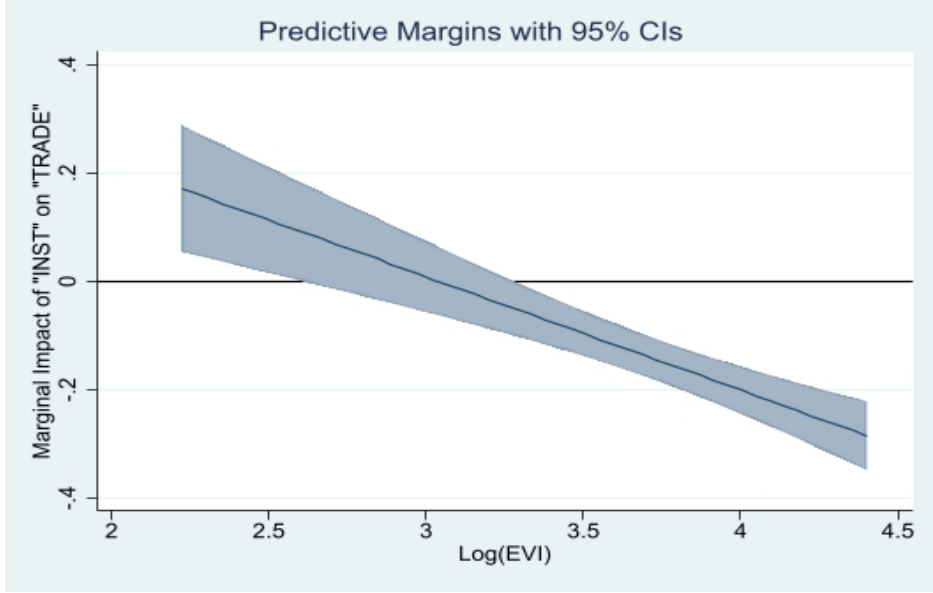
Figure 4. Marginal impact of “INST” on “TRADE” for varying levels of EVI. Source: Author. Outcomes in columns (1) to (4) of Table 1 lend credence to hypotheses 1 to 4 despite Outcomes in columns (1) to (4) of Table 1 lend credence to hypotheses 1 to 4